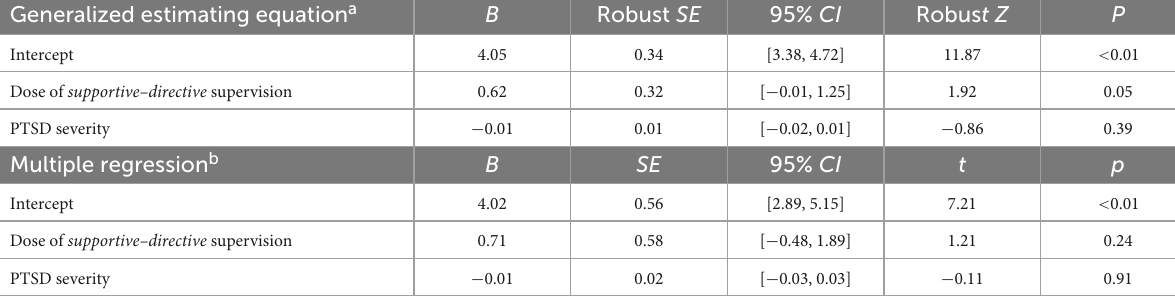
TABLE 7 Model of supportive–directive supervision predicting trauma narrative delivery. Logistic regression a Intercept Dose of supportive–directive